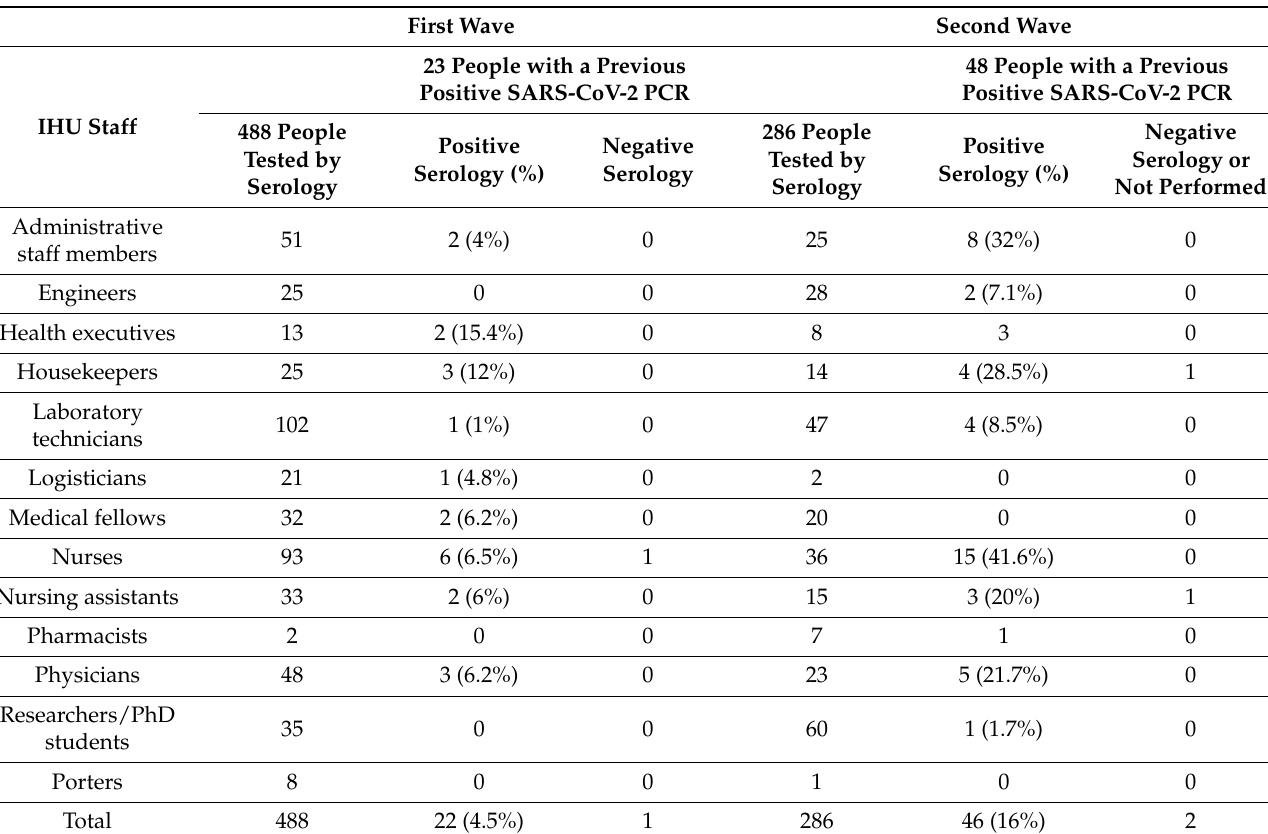
Table 1. Staff screening of the M é diterran é e Infection University Hospital Institute (IHU) for COVID-19 in the first and second waves. First